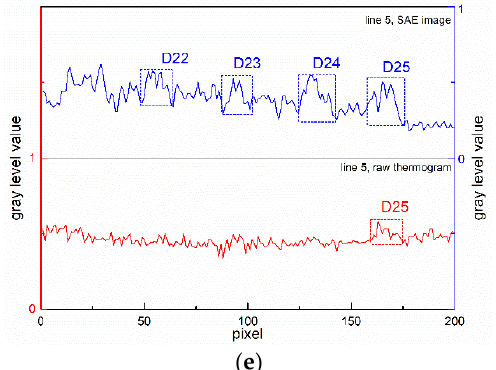
Figure 8. Gray level value variations in the raw thermograms and in the 1st SAE image along the investigation ( a ) line 1, ( b ) line 2, ( c ) line 3, ( d ) line 4, ( e ) line 5 shown in Figure 4.